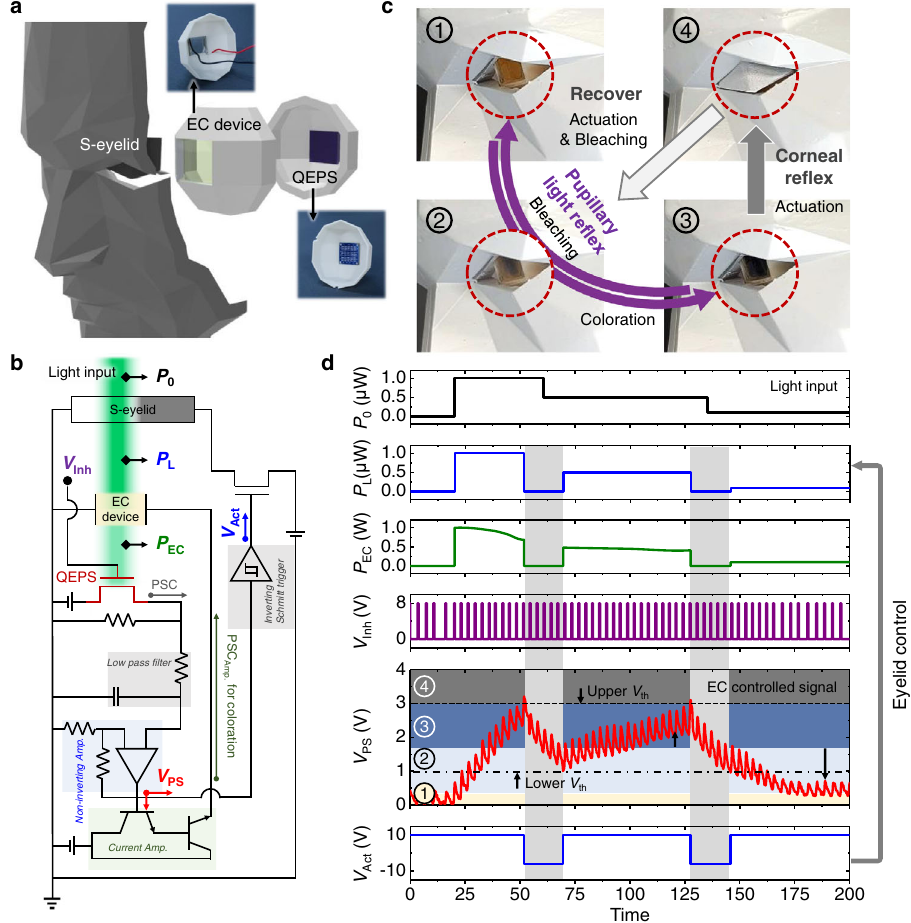
Fig. 4 | Biomimetic ocular prosthesis system capable of corneal re fl ex and pupillary light re fl ex. a Schematic and b circuit diagram of the ocular prosthesis